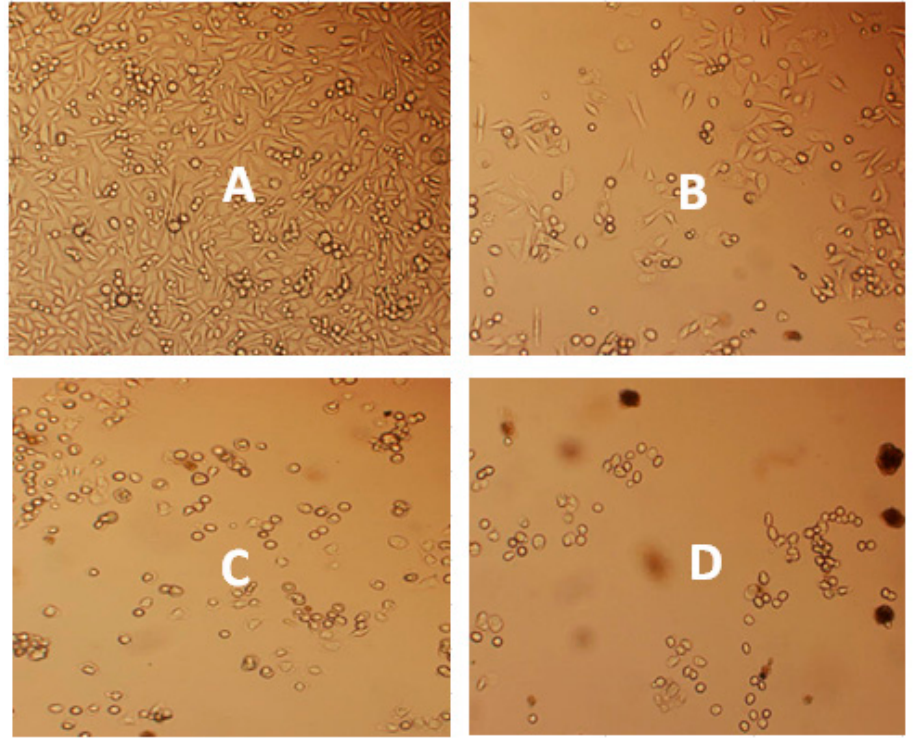
Figure 3. Morphological changes of PC-3 cells were observed under a microscope. The figure shows untreated cells ( A -control) and cells treated with Vernonia amygdalina Delile (VAD) of 125 µg/mL ( B ); 250 µg/mL ( C ); and 500 µg/mL ( D ) for 48 h. Results were confirmed by repeating the experiment three times.